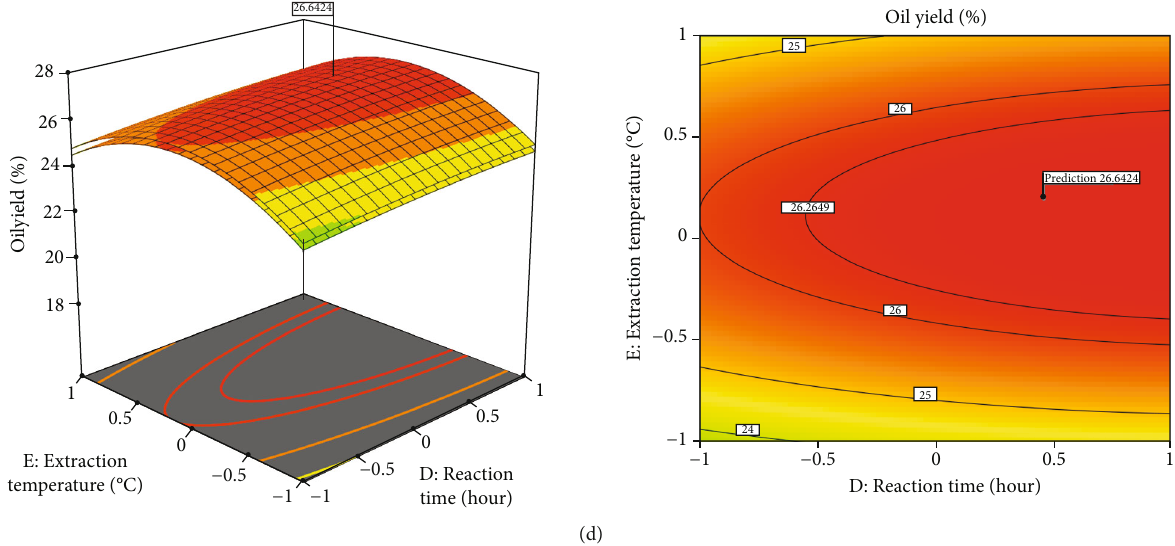
Figure 1: (a), (b), (c), (d) 3D surface plot and contour plot of the e ff ect of oil yield % with the design